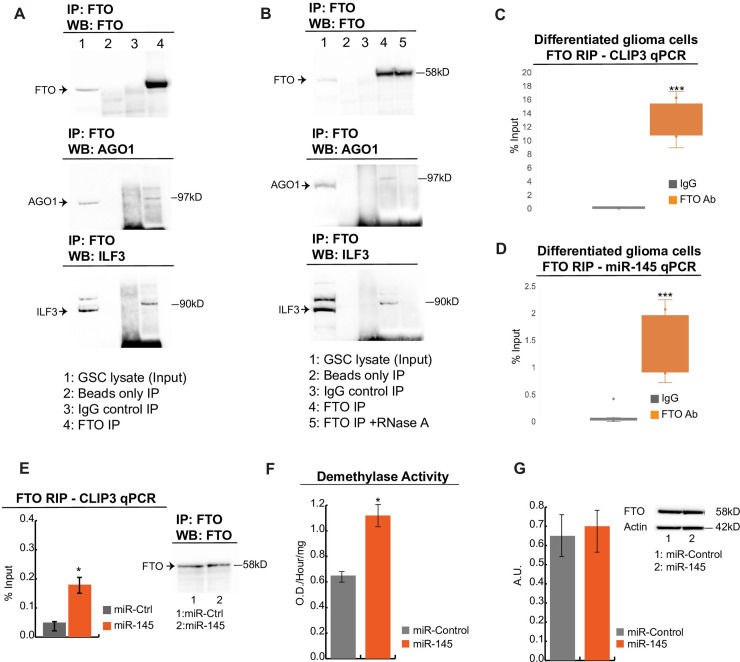
GSC differentiation induces AGO1/FTO/miR-145 complex formation on CLIP3 mRNA and increased FTO demethylase activity.A) Protein lysates of DGCs (lane 1) were immunoprecipitated with FTO antibody (lane 4), isotype matched IgG (lane 3) and Protein A beads (lane 2) as control. Western blot was performed using FTO, AGO1 and ILF3 antibodies, which showed that FTO interacts with both AGO1 and ILF3 in DGCs. Immunoprecipitations were performed in 2 biological replicates. B) Protein lysates of DGCs (lane 1) were immunoprecipitated with FTO antibody in the absence (lane 4) or presence of RNase A (lane 5), isotype matched IgG (lane 3) and Protein A beads (lane 2) as controls. Western blot was performed using FTO, AGO1 and ILF3 antibodies, which shows that the FTO/AGO1/ILF3 complex is RNA-dependent. C) qPCR detection of CLIP3 mRNA immunoprecipitated in complex with FTO/AGO1/ILF3. Results are presented as percent of input sample compared to non-specific immunoprecipitation using isotype-matched IgG (***p<0.001, Student’s t-test). D) qPCR detection of miR145 immunoprecipitated in complex with FTO/AGO1/ILF3 and CLIP3 mRNA. Results are presented as percent of input sample compared to non-specific immunoprecipitation using isotype-matched IgG (***p<0.001, Student’s t-test). E) qRT-PCR detection of CLIP3 following FTO RNA immunoprecipitation (RIP) after transfection of GSCs with non-targeting miRNA (miR-ctrl) or miR-145. miR-145 induces significant increase in binding of FTO to CLIP3 mRNA. Results are presented as average +/- SD from three independent biological replicates. Significance was calculated with a two-way paired Student’s t-test (*p<0.05, df = 4) Western blot insert shows FTO WB following FTO IP on miR-Ctrl and miR-145 transfected cells. F) Transfection of GSCs with miR-145 results in significant increase in cellular demethylase activity. Demethylase activity was calculated with a colorimetric assay using synthetic m6A RNA as substrate and the results are presented as average +/-SD from three independent experiments. Significance was calculated with an unpaired Student’s t-test (*p<0.05, df = 3). G) Transfection of miR-145 in GSCs does not change the protein expression levels of FTO. Western blots were repeated three independent times and the results are presented as average +/- SD. Densitometric quantification was performed using ImageJ.